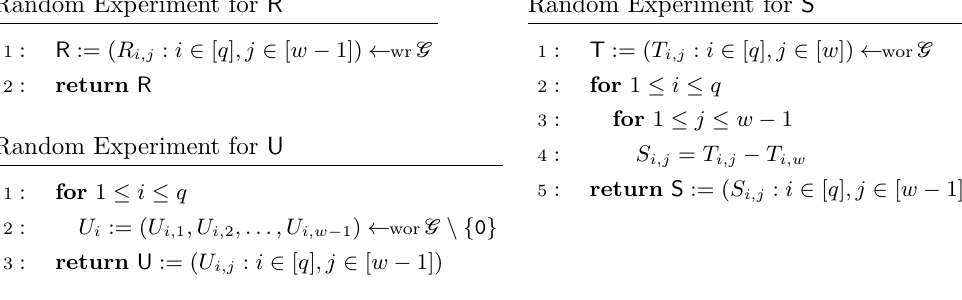
Figure 3.1: Description of sampling methods of random variables R , S and U